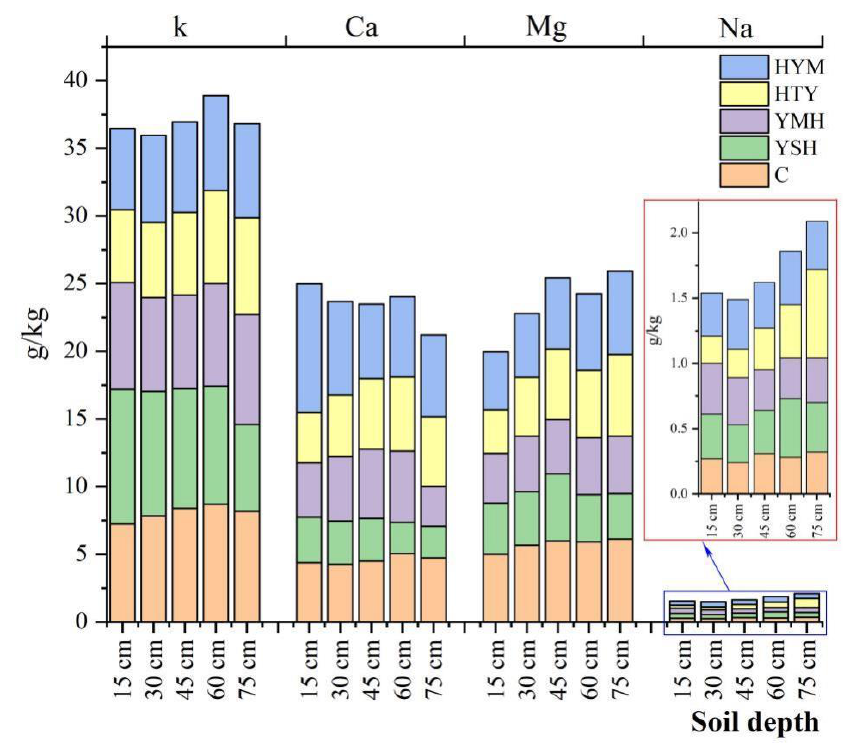
Figure 2. Differences in soil nutrient content. Table 2. Descriptive analysis of soil nutrients.